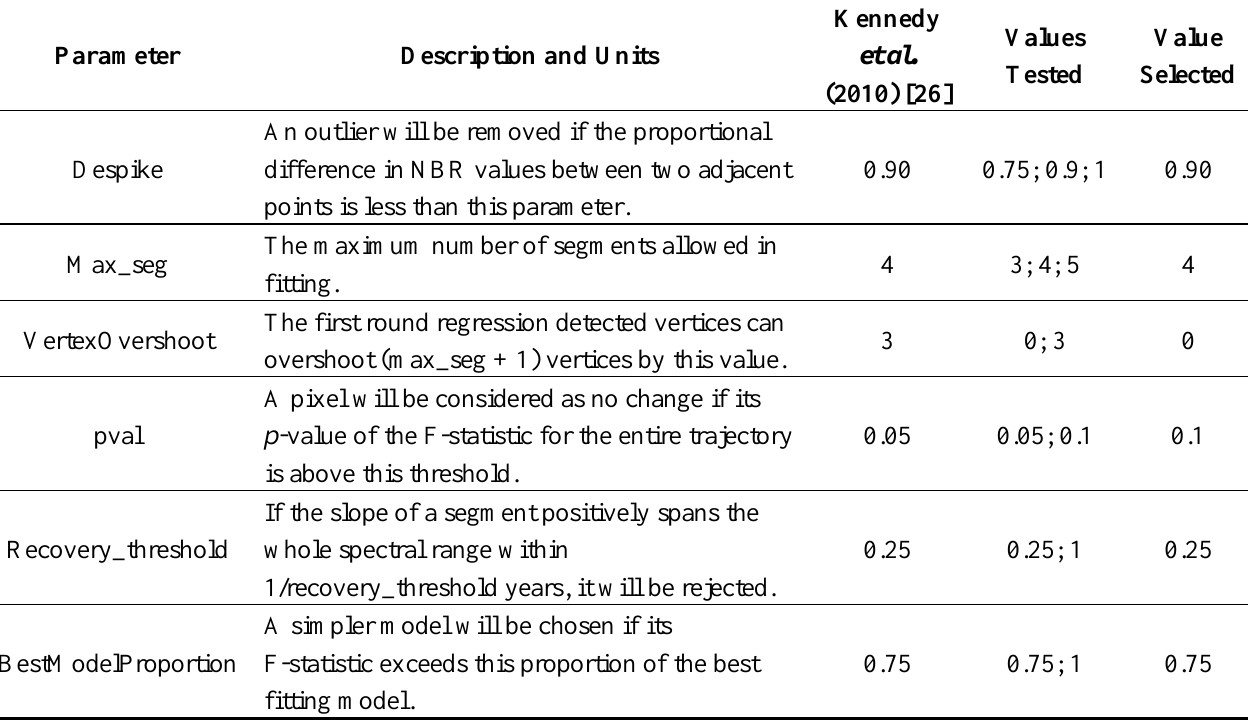
Table 3. LandTrendr parameters, descriptions, suggested values from Kennedy et al. ( 2010) [26] and the values tested for this study and ultimately selected for this study to reduce the raw normalized burn ratio (NBR) time series values to a number of linear